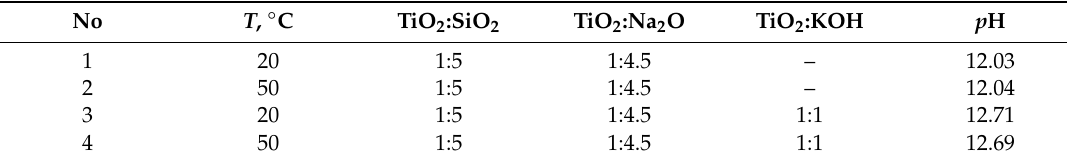
Figure 3. A principal scheme of apatite-nepheline-titanite ore processing for SKR synthesis. Table 1. Experimental conditions of SKR